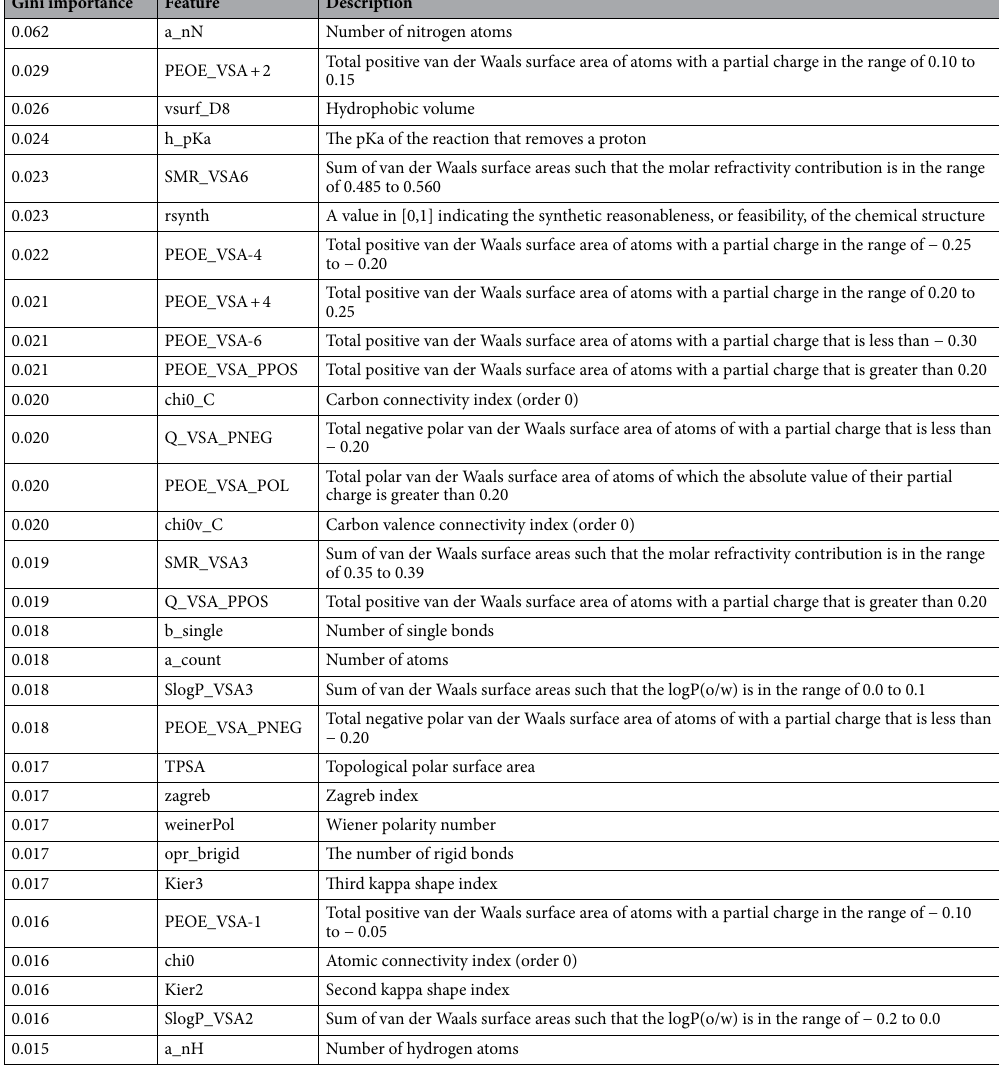
Table 2. Top 30 features ranked by Gini importance for the MD random forest model. The description of the features was taken from the MOE software documentation 23